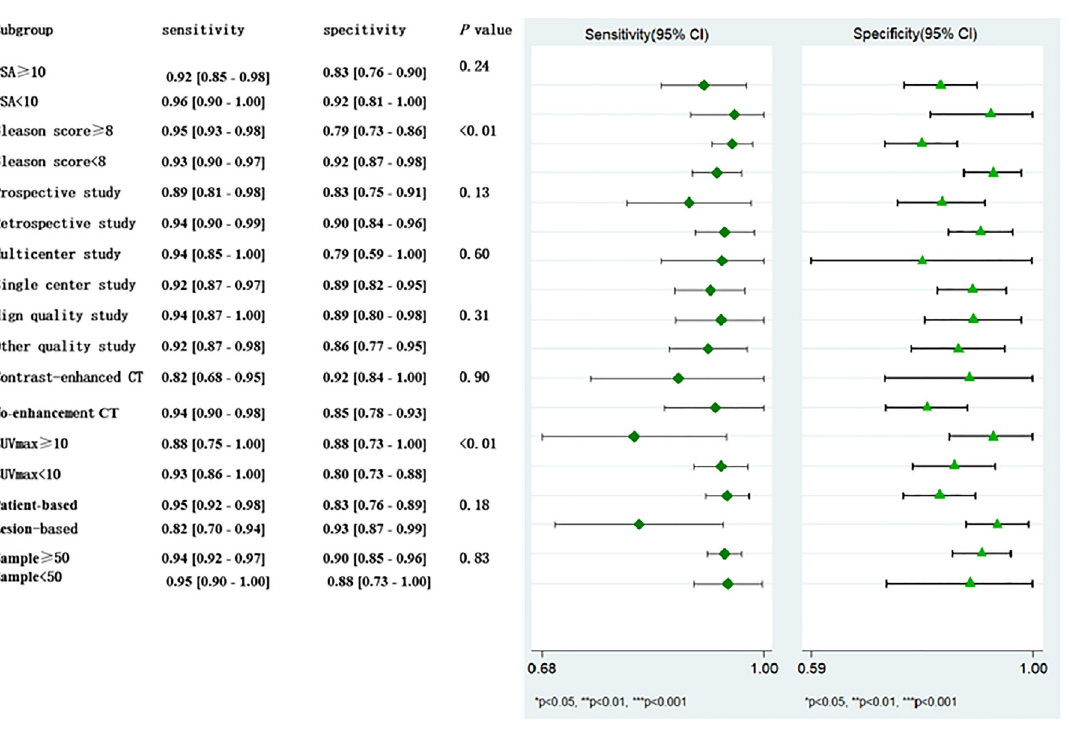
Figure 5 - Forest plot of the sensitivity analysis, showing estimates of the pooled sensitivity and specificity of the various subgroups and the corresponding